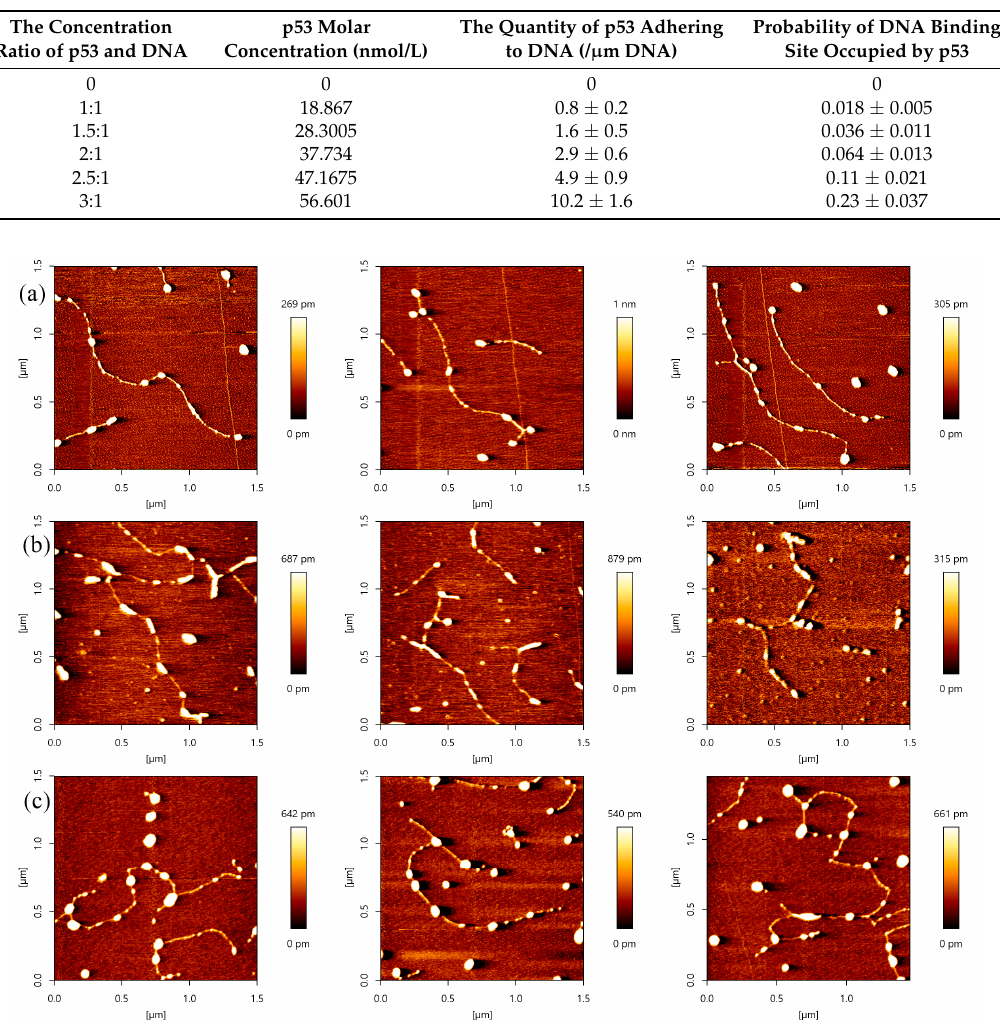
Figure 4. AFM images of p53 and 5000 bp DNA (height images, 1.5 µm × 1.5 µm), when the concentration ratio of p53:DNA is 1:1, 2:1, 3:1, respectively. Meanwhile, the concentration of p53 and DNA are ( a ) 1 and 1 ng/µL; ( b ) 2 and 1 ng/µL; ( c ) 3 and 1 ng/µL, respectively. The environment of the solution is 5 mM Hepes, 3 mM MgCl 2 , pH 7.5.